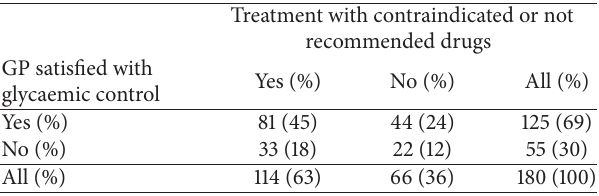
Table 3: GP’s satisfaction with glycaemic control and its association with indication or recommendation of glucose lowering therapy in CKD